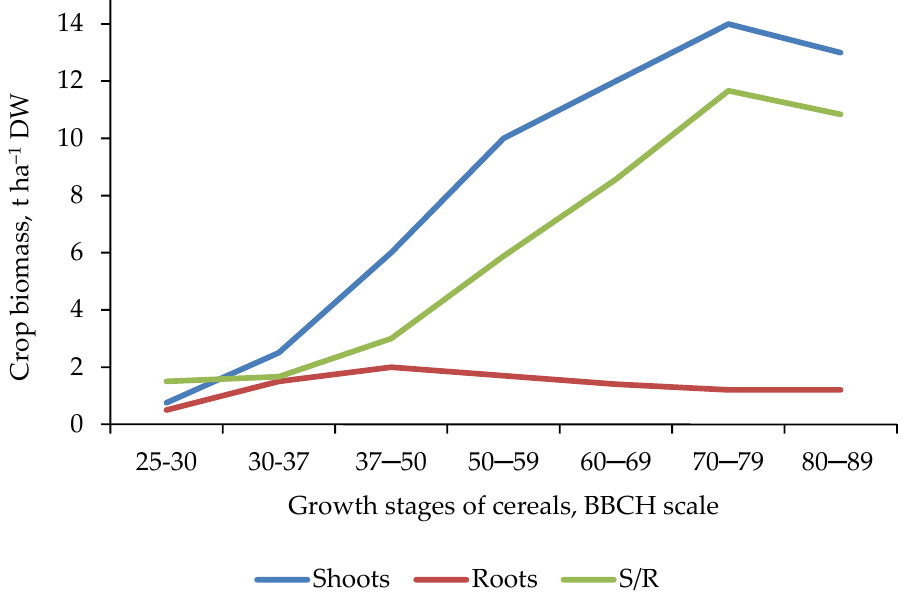
Figure 10. The general pattern of the growth of the root and shoot biomass of cereals during the growing season (based on Grzebisz [70]). Legend: R/S—root to shoot biomass ratio.